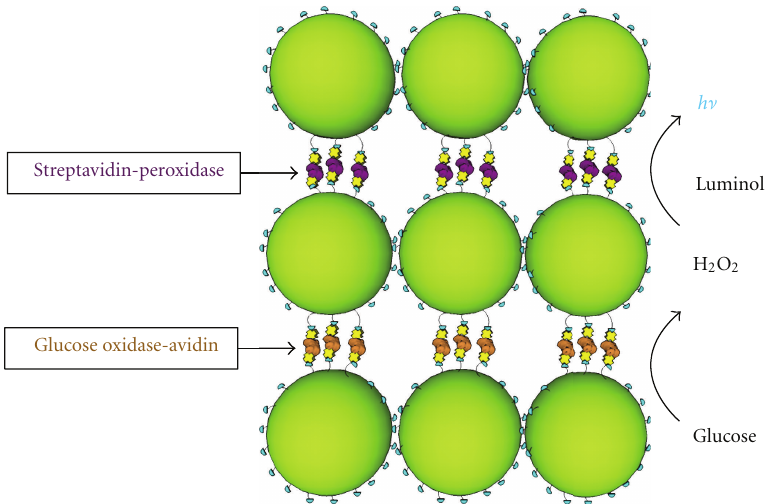
Figure 8: Coupling of bi-enzyme NP layers. The incorporation of both streptavidin-HRP and GOx-avidin into the same layer structure may allow for chemical coupling of the layers. The oxidation of glucose by GOx produces hydrogen peroxide which is then a substrate for the chemiluminescent oxidation of luminol, which generates light that can be